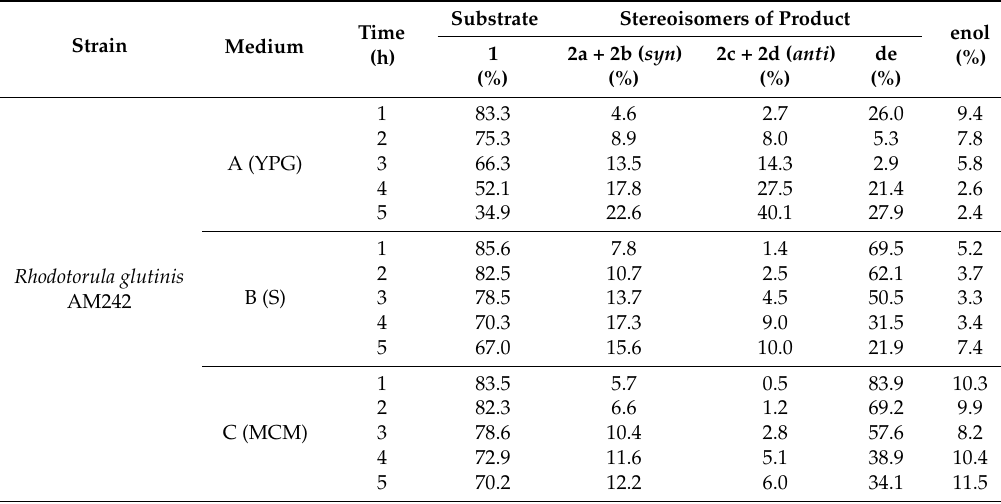
Table 1. The results of biotransformation of α -acetylbutyrolactone 1 by R. glutinis AM242 in different media (in % according to GC (chiral column)). YPG: Yeast extract-Peptone-Glucose medium; MCM: Mushroom Complete Medium.